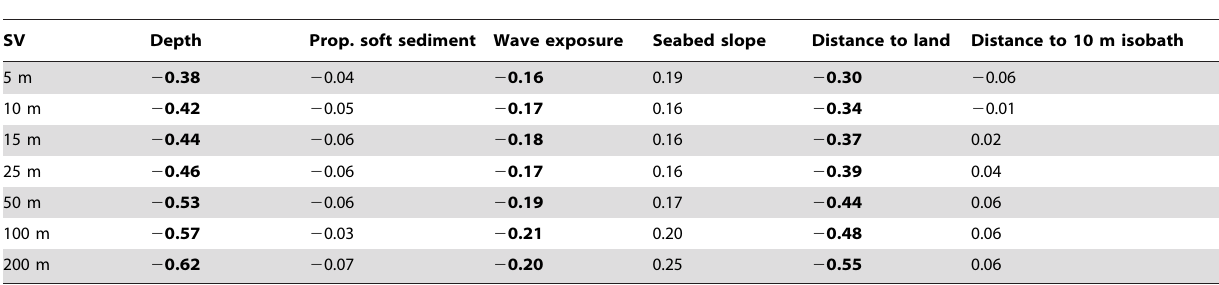
Table 5. Correlations between spectral variability (SV) at different spatial scales and environmental variables.